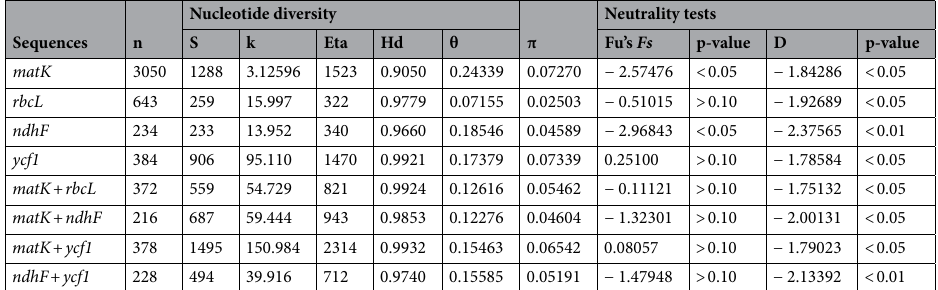
Table 4. Genetic diversity caculation of Orchidaceae plants based on candidate barcode sequences by the DnaSP v5 software. Eta Total number of mutations, n number of sequences, k Average number of